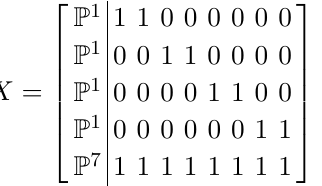
Figure 3 . An example of the data describing a (cid:12)bration of a quotiented CICY where the (cid:12)bration and symmetry being considered are not